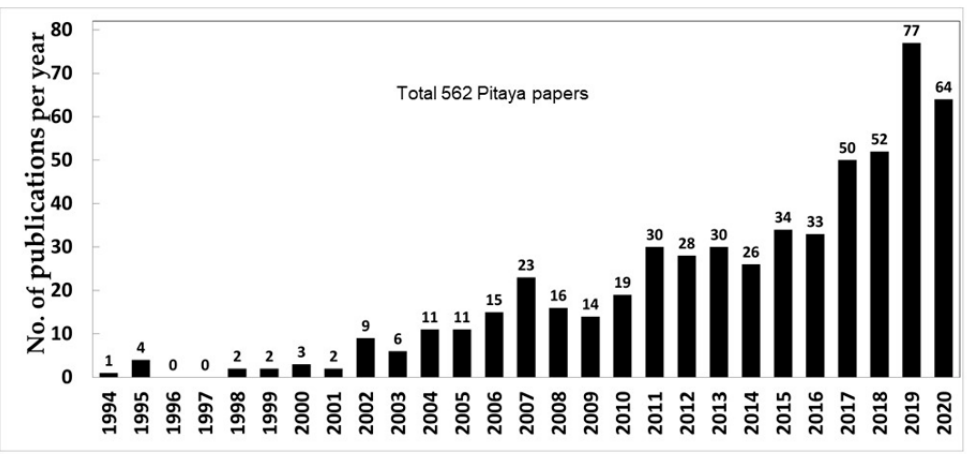
Figure 1. Number of scientific publications per year on pitayas. Taken from Web of Science.